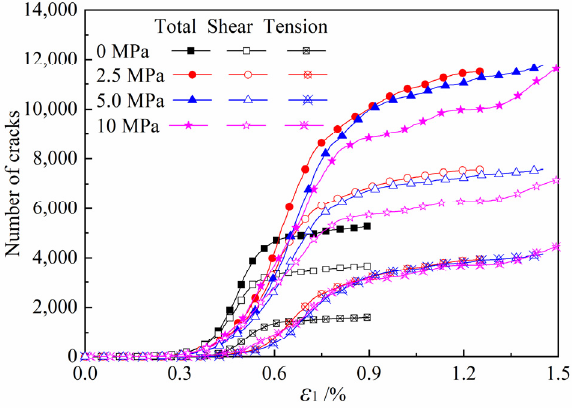
Figure 15. Growth process of crack number in RAC20 under different confining pressures.